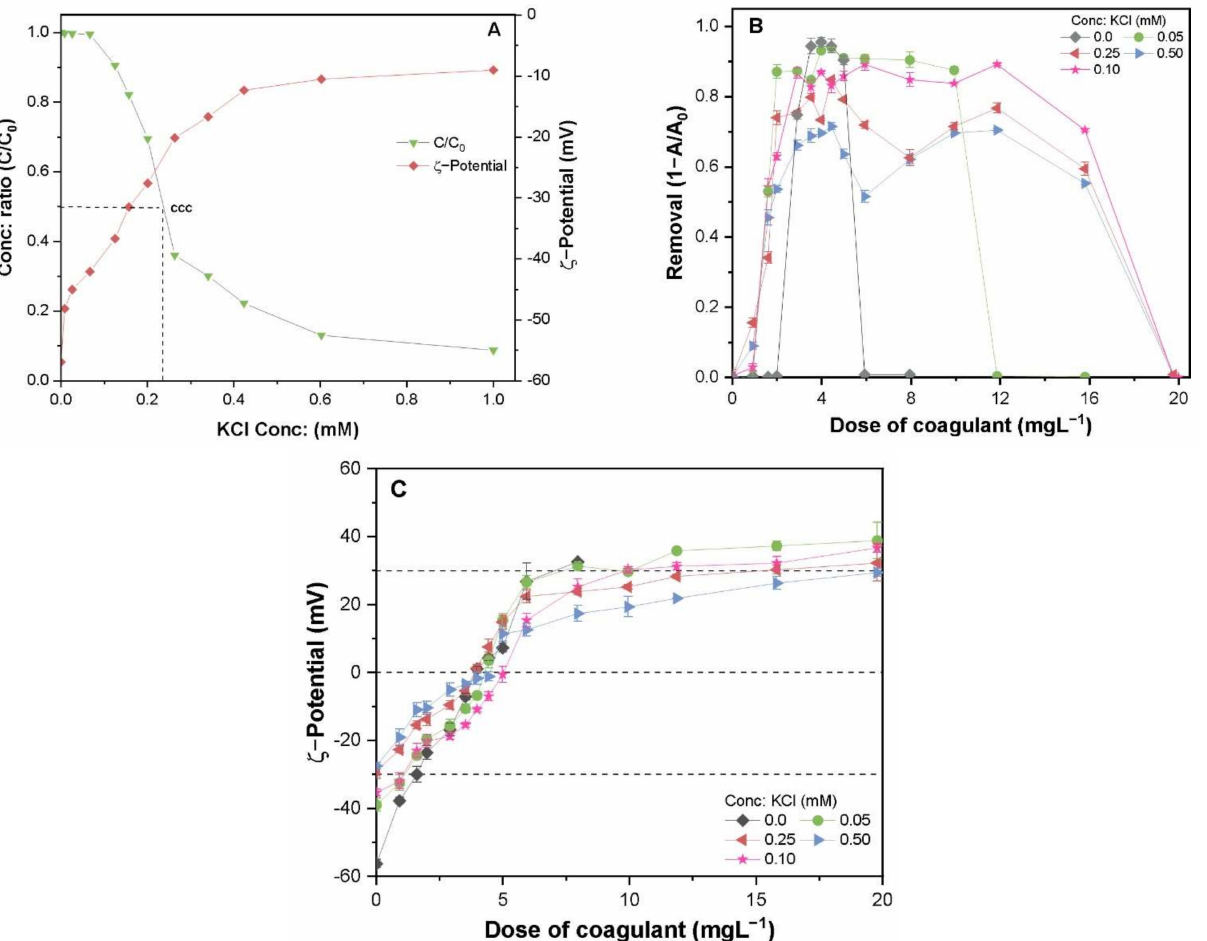
Figure 5. Effect of various KCl concentrations on TA-CuO NPs ( A ) stability (C/C 0 ); ( B ) removal efficiency by PAFC, and ( C ) corresponding ζ -potential at various dosages of